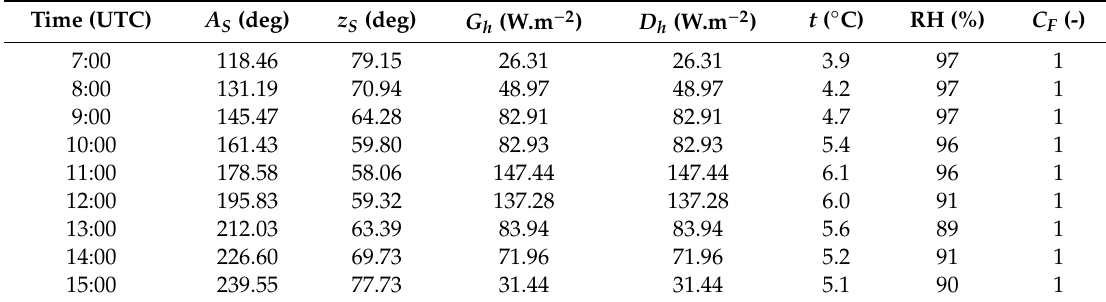
Table 2. The same as in Table 1, but for 24 February 2015 (overcast sky).